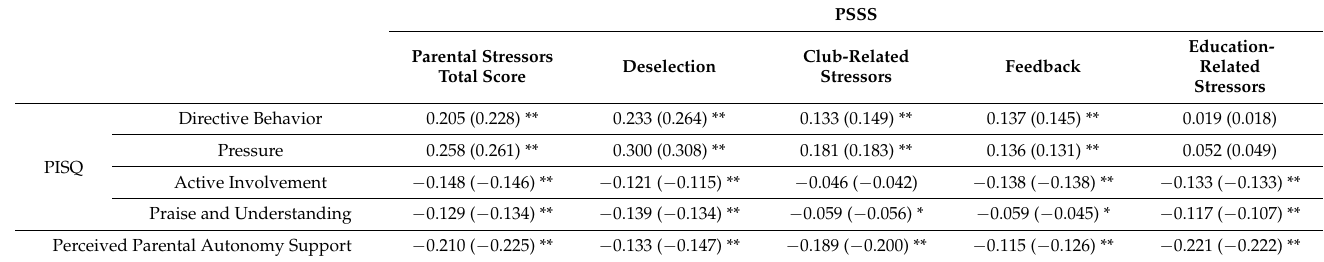
Table 5. Correlations between parental involvement and parental